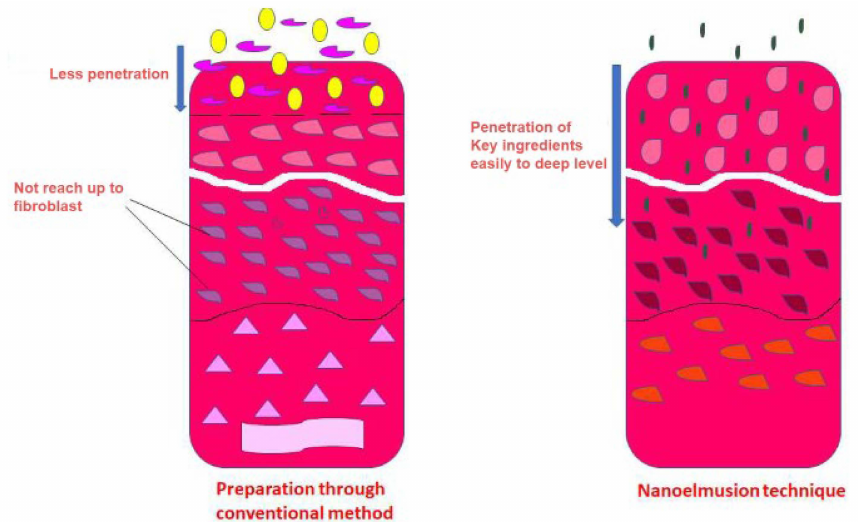
Figure 4. Comparison of nanoemulsions with the conventional transdermal formulations in the case of crossing skin barrier